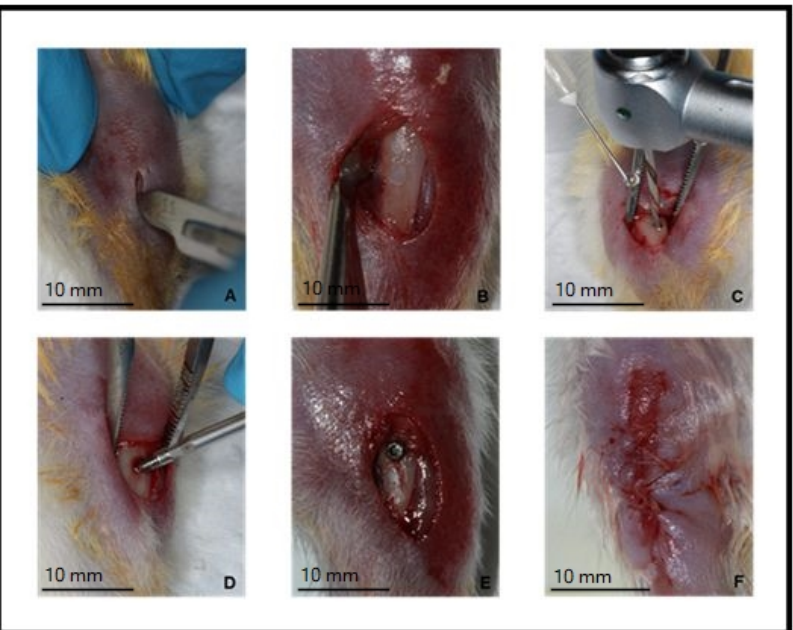
Figure 2. Surgical sequence for implant installation. ( A )—Incision of approximately 1.5 cm parallel to the tibial axis; ( B )—flap reflected; ( C )—drilling under constant saline irrigation; ( D )—installation of the implant; ( E )—implant positioned; ( F )—sutured flap.